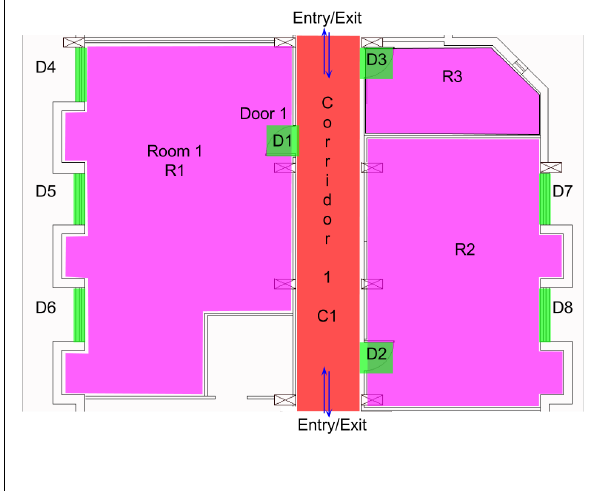
Figure 2: Spaces marked as rooms(pink), corridors(red) and doors/windows(green)